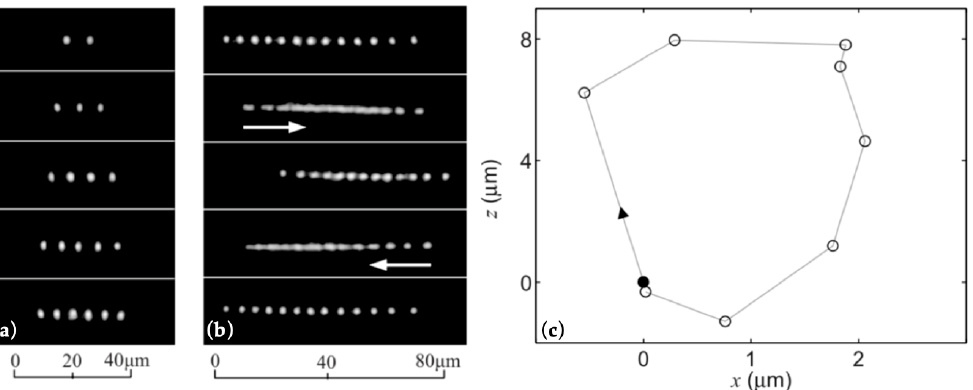
Figure 5. Multiple trapping and manipulation with the dual-beam fiber trap [51]. ( a ) Optical trapping of multiple objects. ( b ) Optical oscillating of a linear array of 13 objects. ( c ) Trajectory of the outermost polystyrene microsphere (PSM) for eight PSMs. The laser power of each fiber is 100 mW at 980 nm, and the objects are PSMs of with 1 μ m diameters.